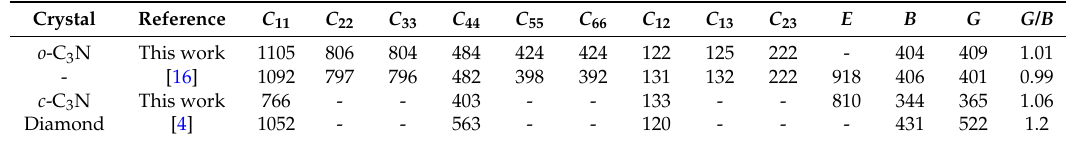
Figure 3. Phonon dispersion of c -C 3 N at 0 GPa ( a ) and 100 GPa ( b ) and R 3 m -C 3 N at 0 GPa ( c ) and 100 GPa ( d ). Table 2. The calculated elastic constants C ij (GPa), Young’s modulus E (GPa), bulk modulus B (GPa), shear modulus G (GPa), and the G / B ratios of o -C 3 N, c -C 3 N, and diamond.